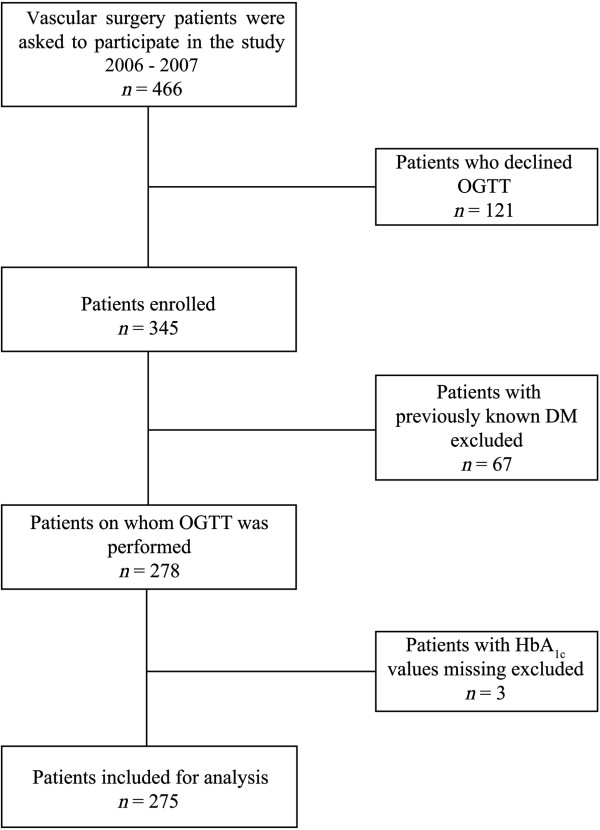
Flow chart. The selection of patients admitted consecutively to the vascular surgery unit at Haukeland University Hospital, Norway, for elective surgery between October 2006 and September 2007.